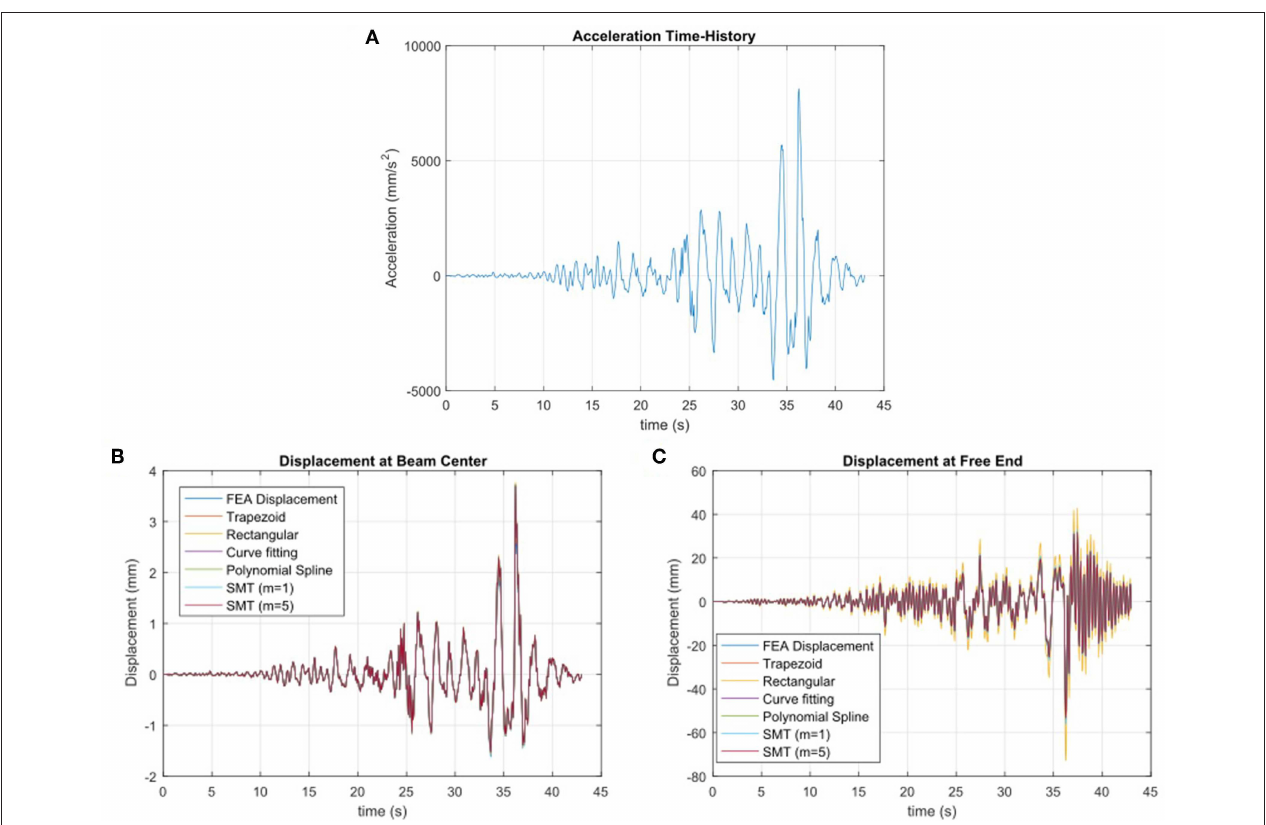
FIGURE 4 | (A) Acceleration time-history applied to the FEA beam model, modified from PEER (2013), (B) Center displacement for FEA transient analysis of a simply supported beam, and (C) Free end displacement for FEA transient analysis of a cantilever